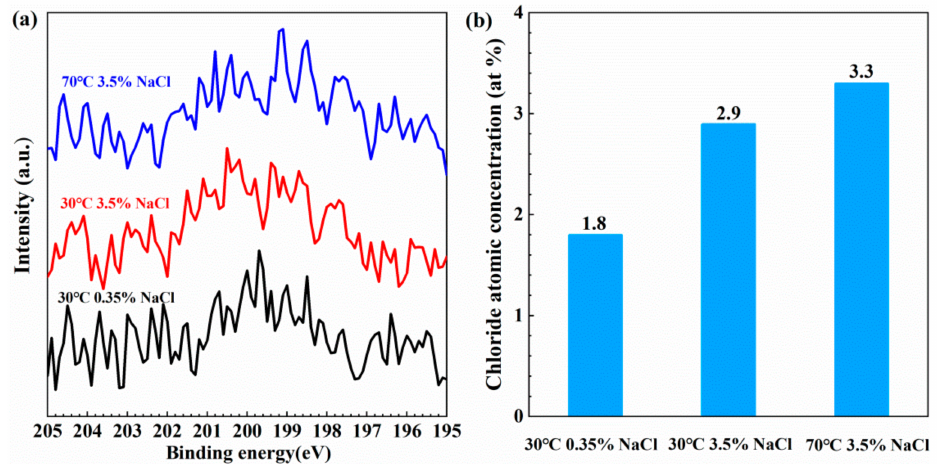
Figure 10. The detailed XPS spectra of Cl 2p ( a ) and the chloride atomic concentration determined by XPS ( b ) for the surface film on Fe-based AMCs after 10 s sputtering in the NaCl solution with various concentration and